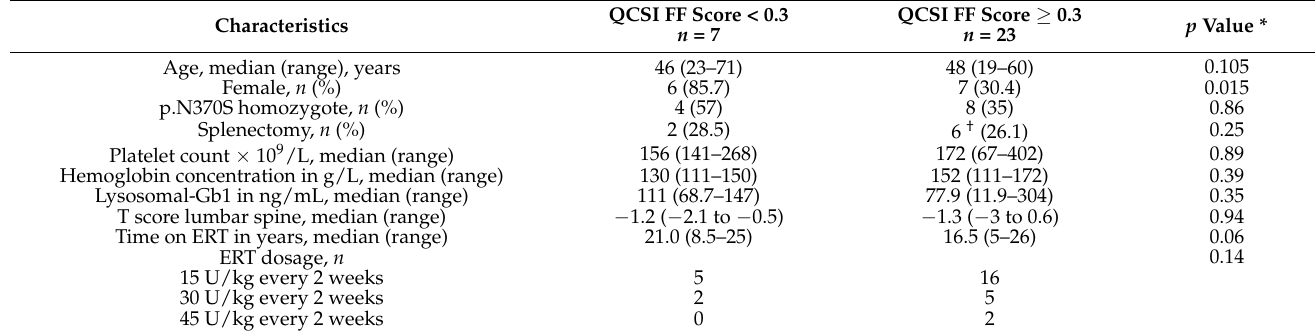
Table 1. Characteristics of patients with low QCSI scores (<0.3) and normal QCSI scores.